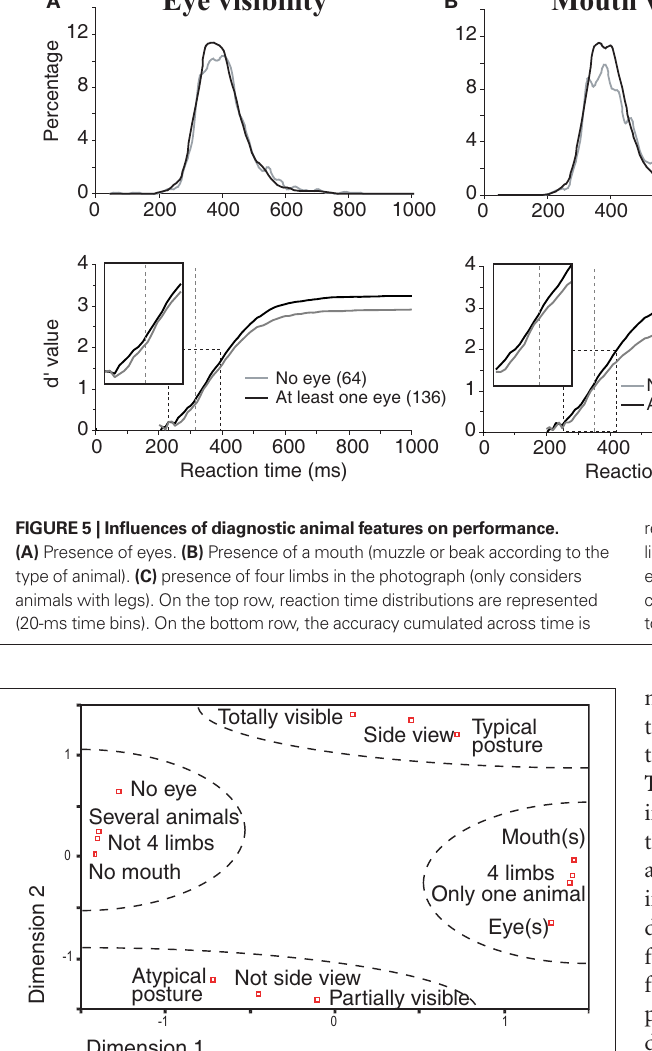
Figure 6 | Classes of animal features were decomposed in a multidimensional space using principal component analysis. For each class, the distance with other classes correspond to the proportion of common images between the two classes. All classes have thus coordinates in a multidimensional space and PCA extracts the two first principal dimensions. This representation makes it possible to estimate distance between classes (i.e. the rate of co-occurrence of image characteristics). Complementary classes of characteristics (“partially visible”/“Totally visible” for example) are symmetrical compared to the origin in this space. Very clearly four groups, manually separated in dotted lines, are profiled. This representation only depends on image